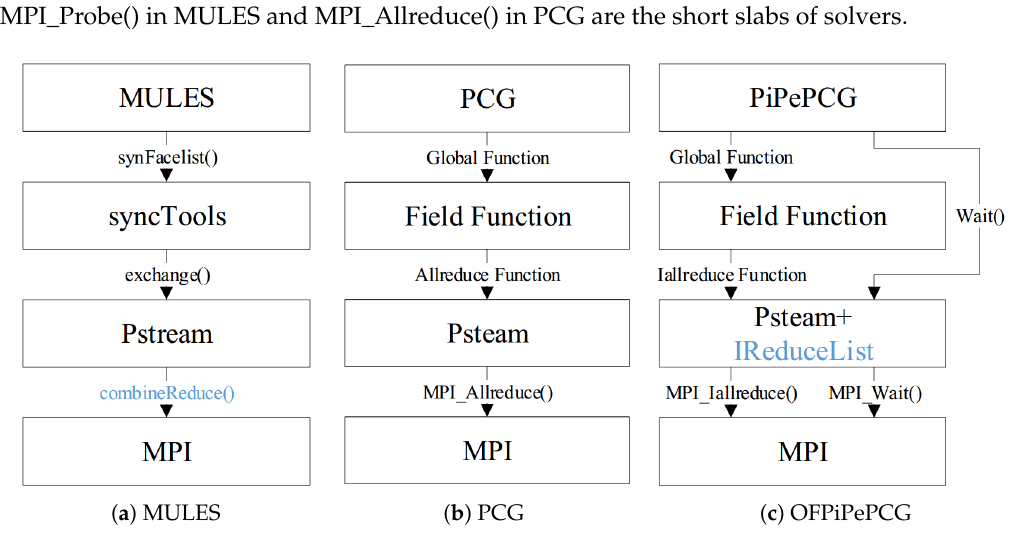
Figure 6. The Call Graphs of Communication in PCG, MULES, and OFPiPePCG. Generally, the communication operations are abstracted as several interfaces in different libraries. Blue font indicates the key optimization. MULES realizes synchronization by synFacelist(), which will call exchange() in Pstream to finish communication. In order to get the size of sync message, exchange() will call the combineReduce(), which will invoke MPI_Probe(). For PCG, during each iteration, two dot products are required for each step, and each dot product operation requires a global communication because the elements of one vector or tensor are distributed on different processes. The global dot product function in Field Function will invoke the Allreduce Function in Pstream, through which the MPI_Allreduce() is called. ( a ) MULES; ( b ) PCG; ( c )